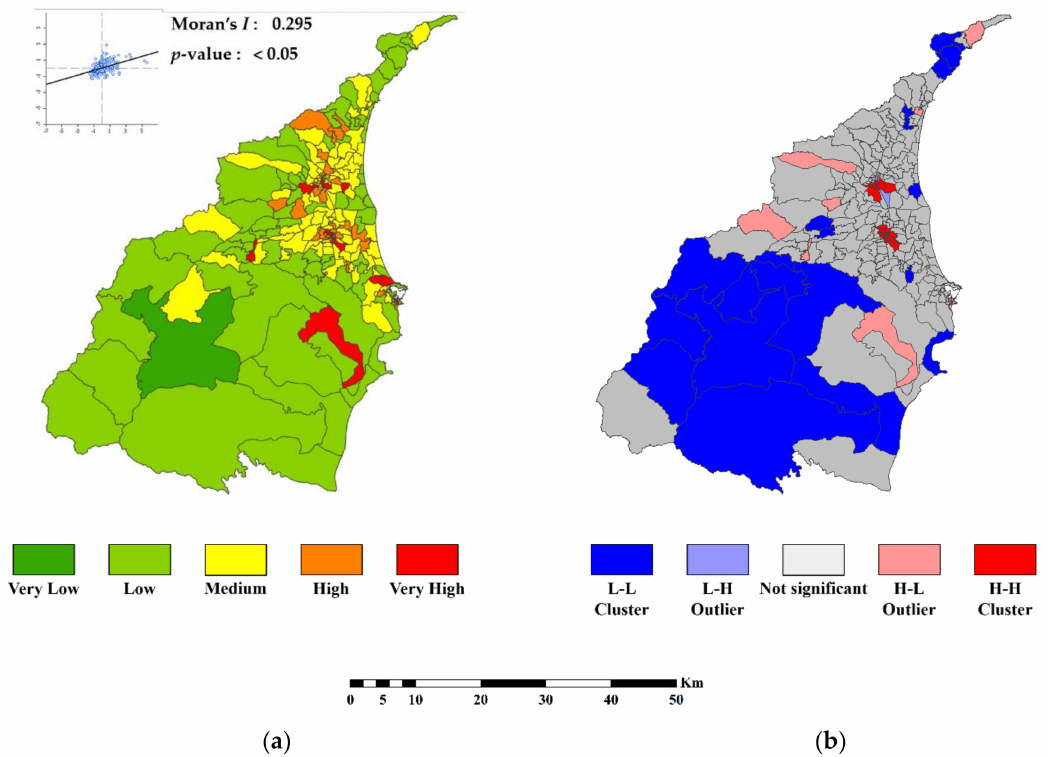
Figure 5. The distribution and cluster map of BRIC in the community; ( a ) the spatial distribution and result of global spatial autocorrelation analysis; ( b ) the result of LISA and cluster